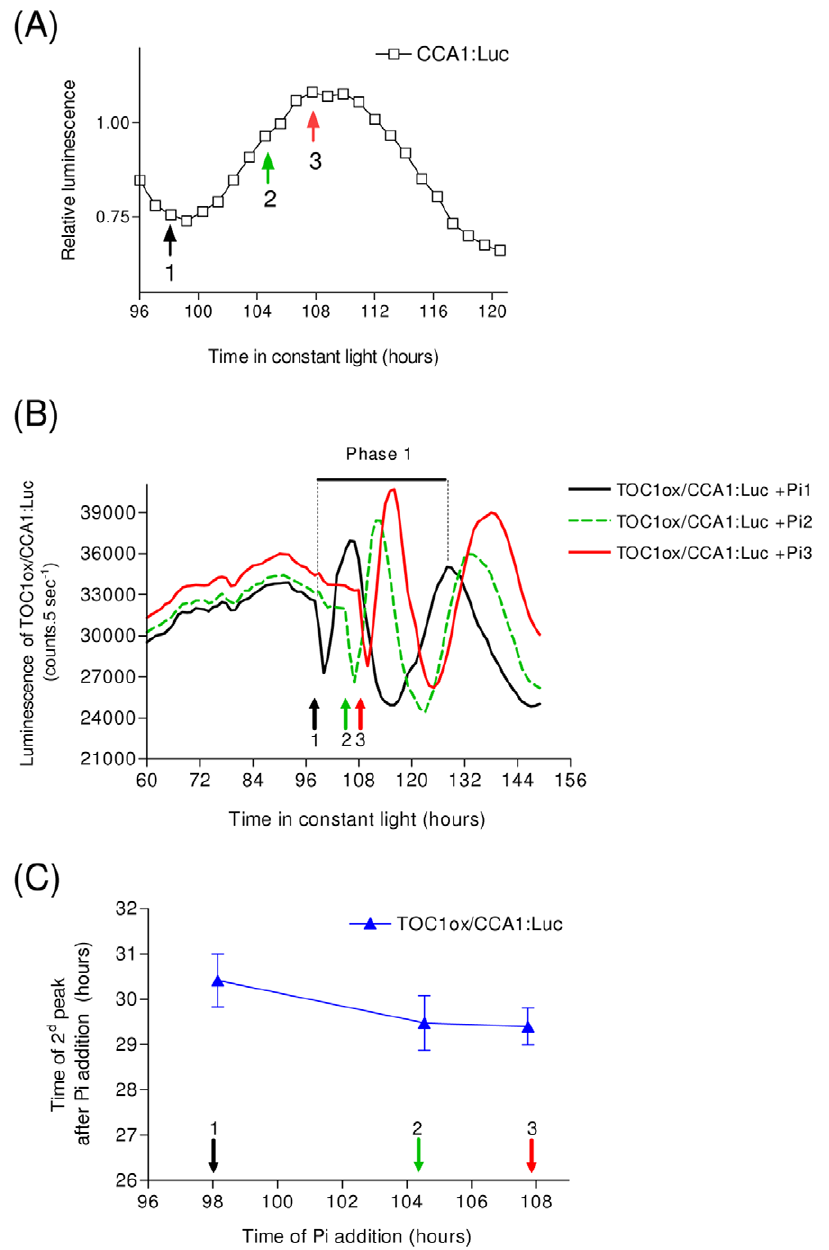
Figure 6. Analysis of TOC1 circadian function. ( A ) Experimental protocol. Luciferase reporter lines CCA1:Luc and TOC1ox/CCA1:Luc were released in constant light at Time 0 after an initial synchronization by a 6 hour dark pulse. Pi was added at a 30 m M final concentration at three different times (t1=98, t2=104 and t3=108 hours). Arrows indicate the three times of Pi addition relative to the phases of CCA1:Luc control line ( B ). For the three times of Pi addition, a rhythmic expression pattern of CCA1:Luc was recovered. The phase of CCA1:Luc peak of expression relative to the time of Pi injection was determined on the second peak of CCA1:Luc (e.g. Phase 1 corresponds to the time t1 of Pi addition). ( C ) The phase of CCA1:Luc peak of expression is plotted as a function of the time of Pi addition. Note that for the three times, no circadian gating of CCA1:Luc response is observed (N=3, 6 SD).